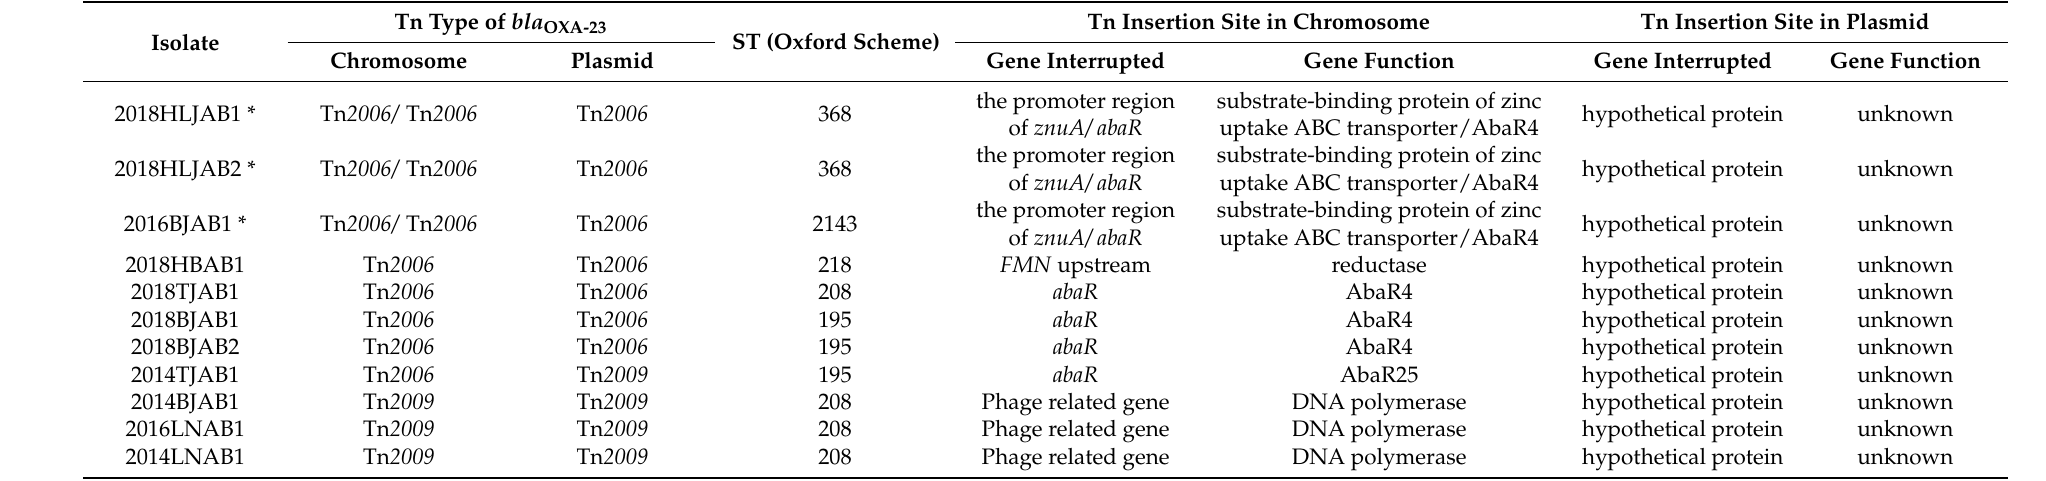
Table 3. The distribution of bla OXA-23 -containing transposon and insertion site among the CO isolates.